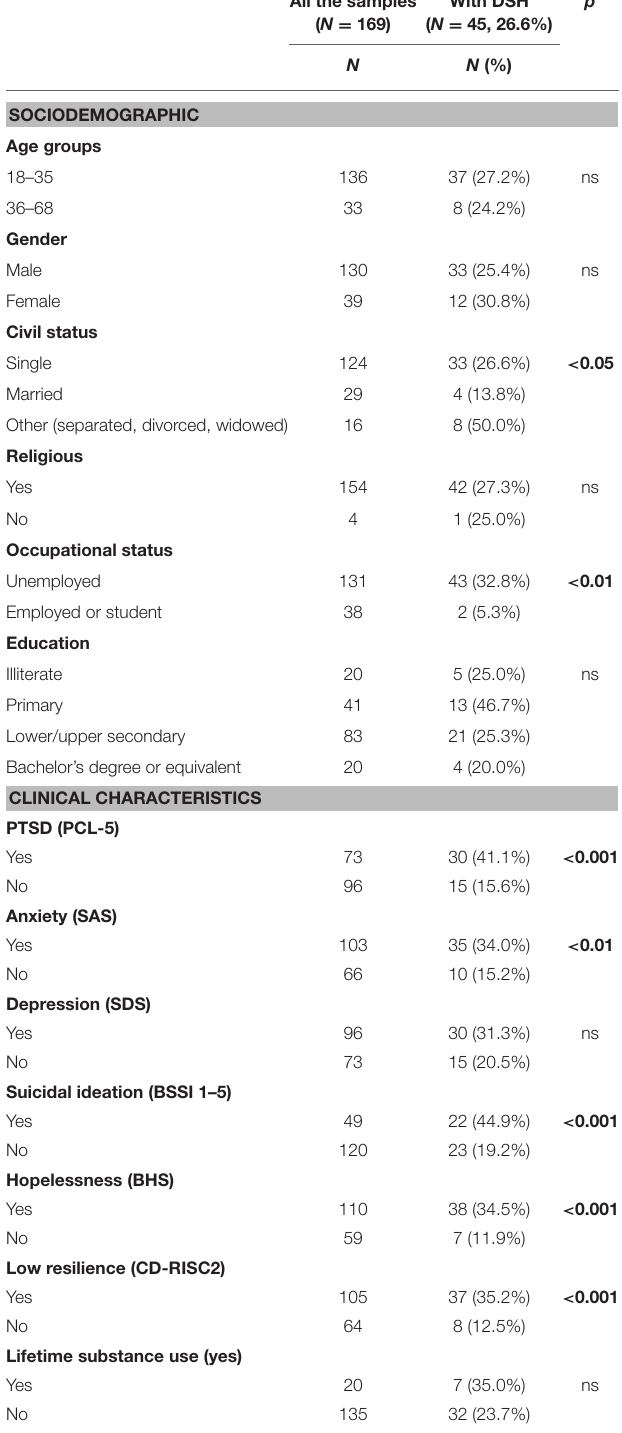
TABLE 3 | Characteristics of migrants who injure themselves. All the samples ( N = 169)